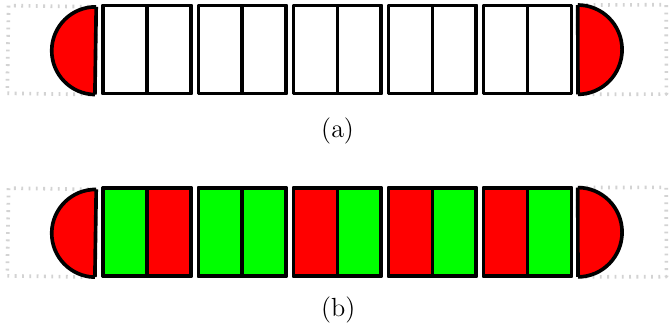
Figure 9. ( a ) Ising program I ( n ) for the case n = 5, k = 1. ( b ) The structure of an optimal tiling of I ( n ) . In such tiling, adjacent halves of neighboring tiles should be in different